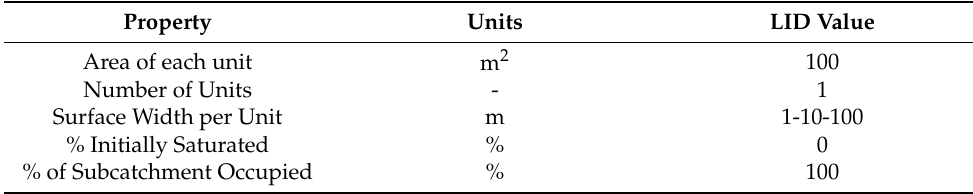
Table 3. SWMM parameters for LID implementation into the LID subcatchment. Property Units LID Value Area of each unit m 2 100 Number of Units - 1 Surface Width per Unit m 1-10-100 % Initially Saturated % 0 % of Subcatchment Occupied %